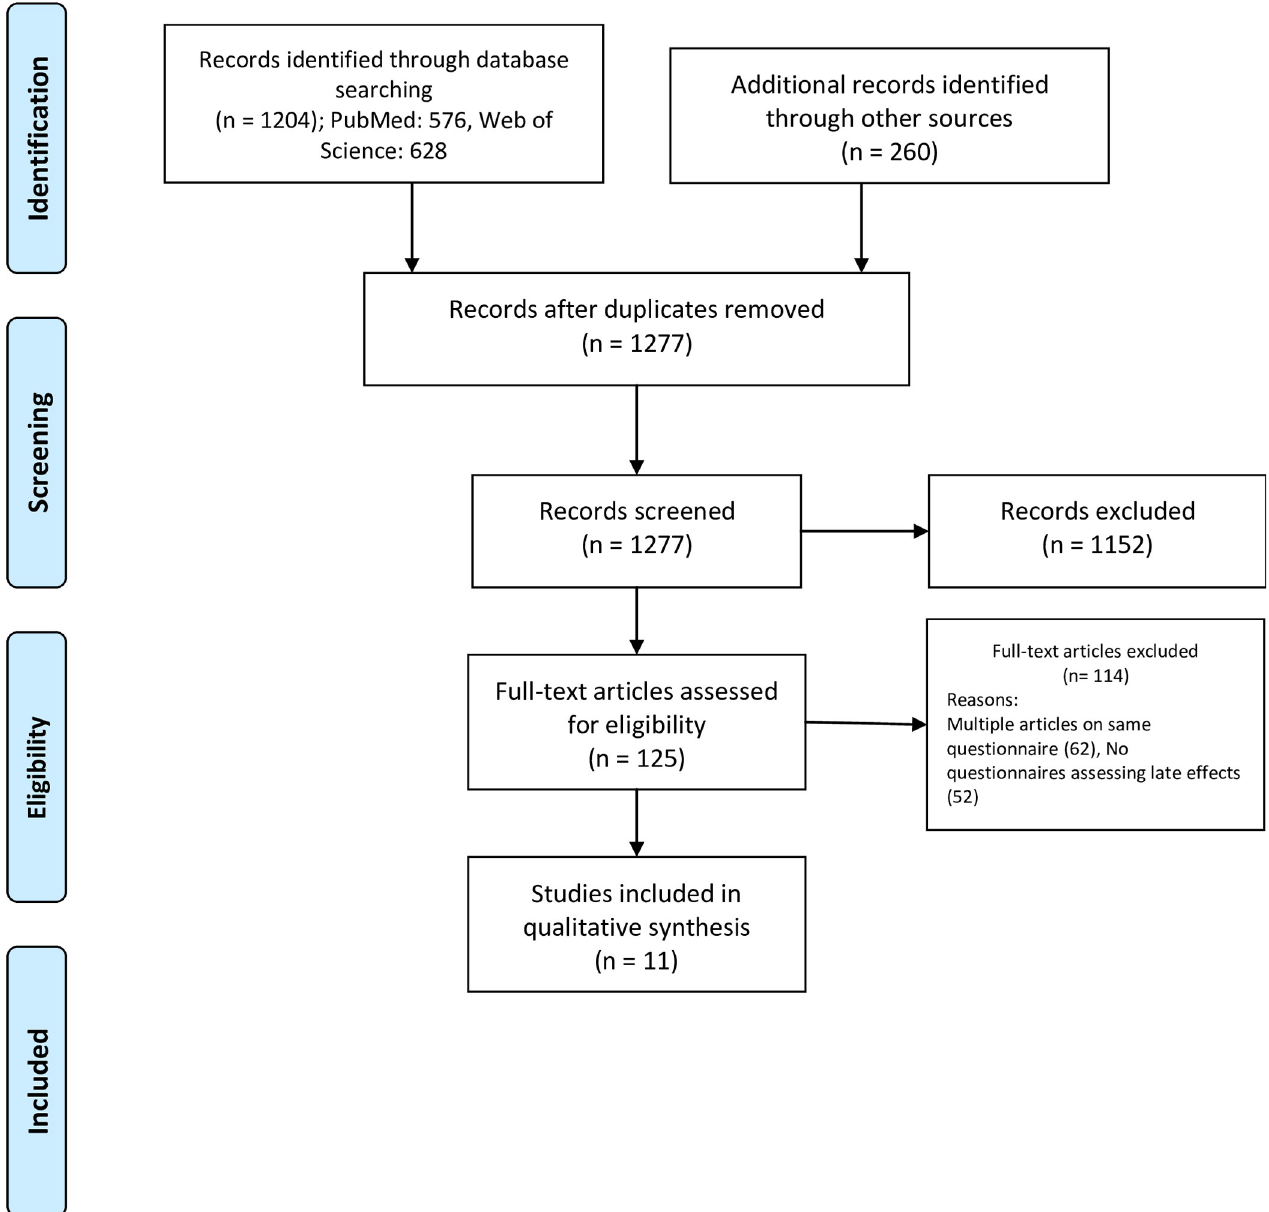
Fig 1. PRISMA flowchart for demonstrating the process of identification, assessment, and inclusion of studies in the systematic review.